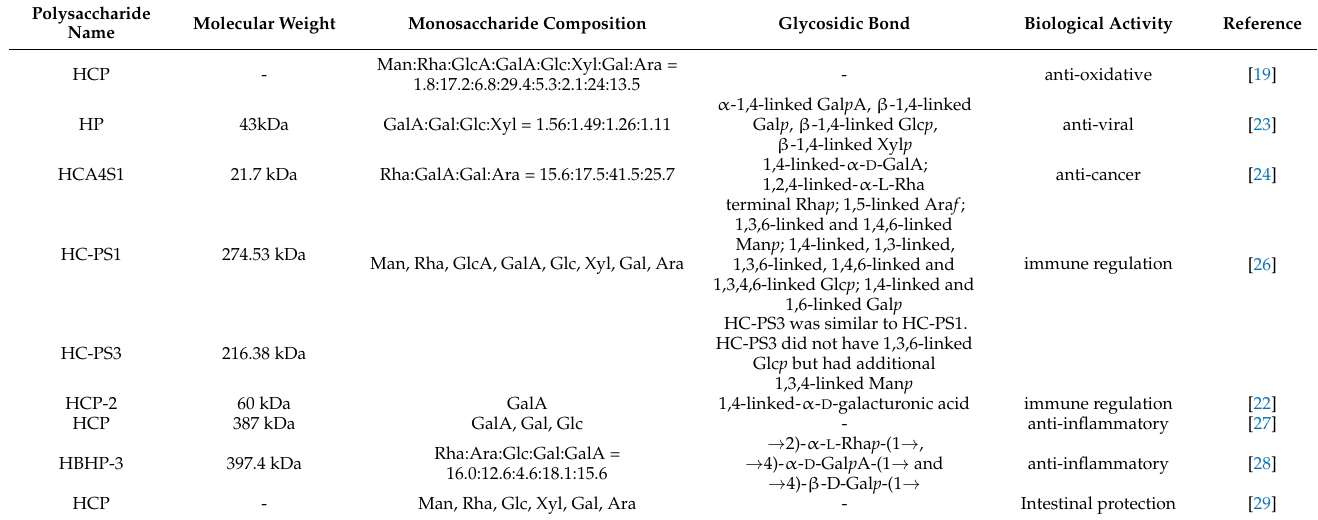
Table 1. Structural characterization and biological activities of Houttuynia cordata